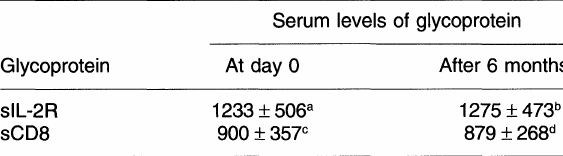
Table 2. Serum levels (mean _+ S.D.) of soluble IL-2R and CD8 in 22 patients at day 0 after 6 months Serum levels of